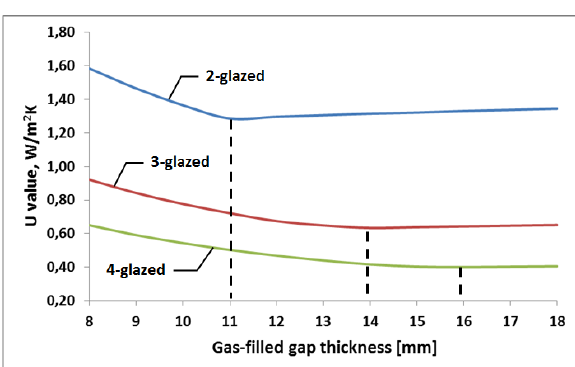
outside air side, the exterior glass pane is marked as “ex”, the interior glass pane is marked as “in”, while the remain- ing glass panes are labelled with the index with the cham- bers encasing them numbered in order.